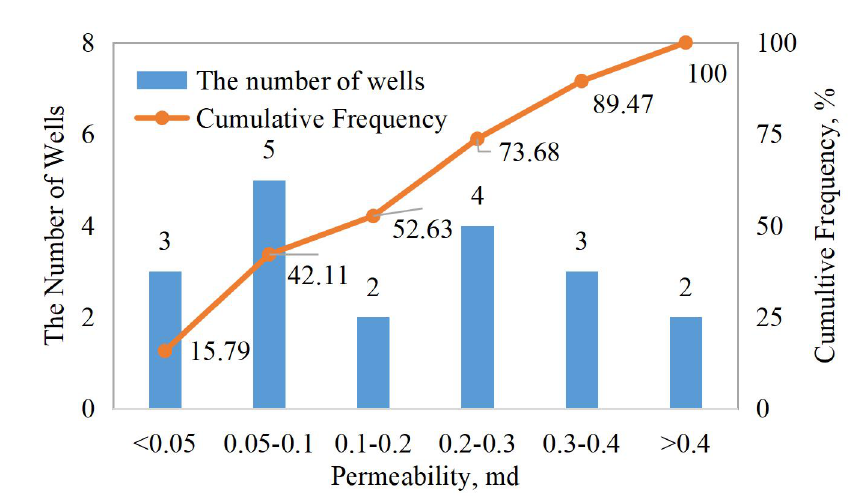
Figure 11—Cumulative frequency distribution of vertical wells